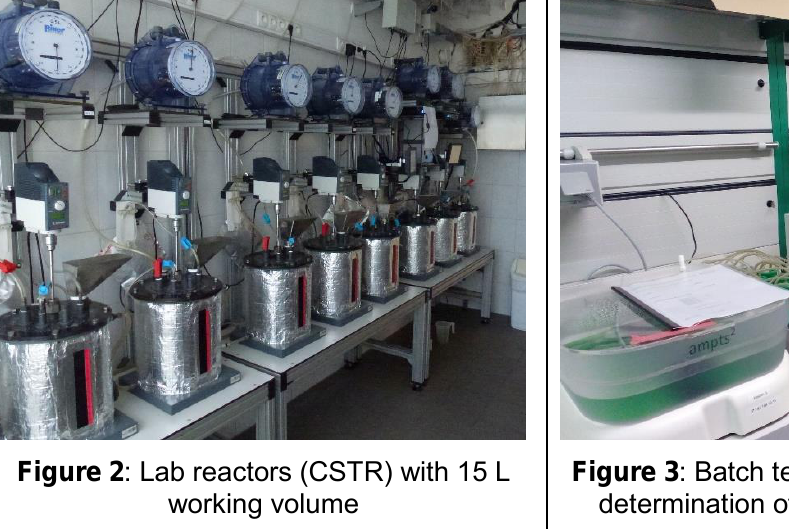
Figure 2 : Lab reactors (CSTR) with 15 L Figure 3 : Batch test system for automated working volume determination of Biomethane potential